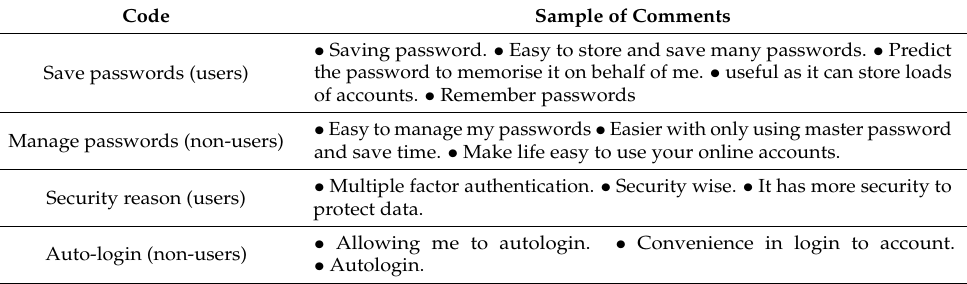
Table 9. Comments sample for the question “What do you like the most?”.